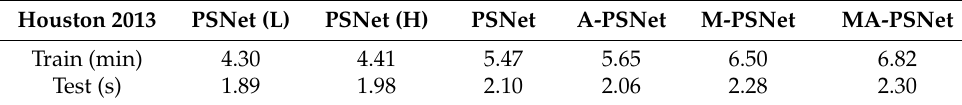
Table 6. The computation time of different models on the Houston 2013 dataset.